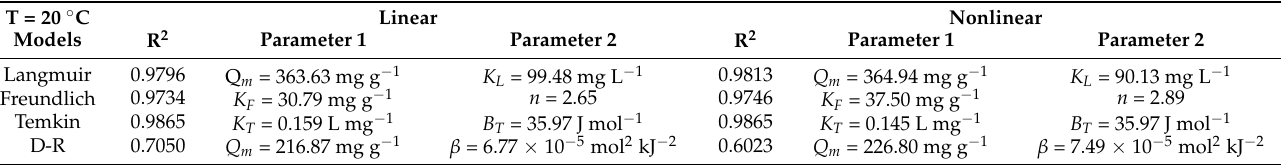
Table 2. Summary of isotherm parameters of GST adsorption on GPG.